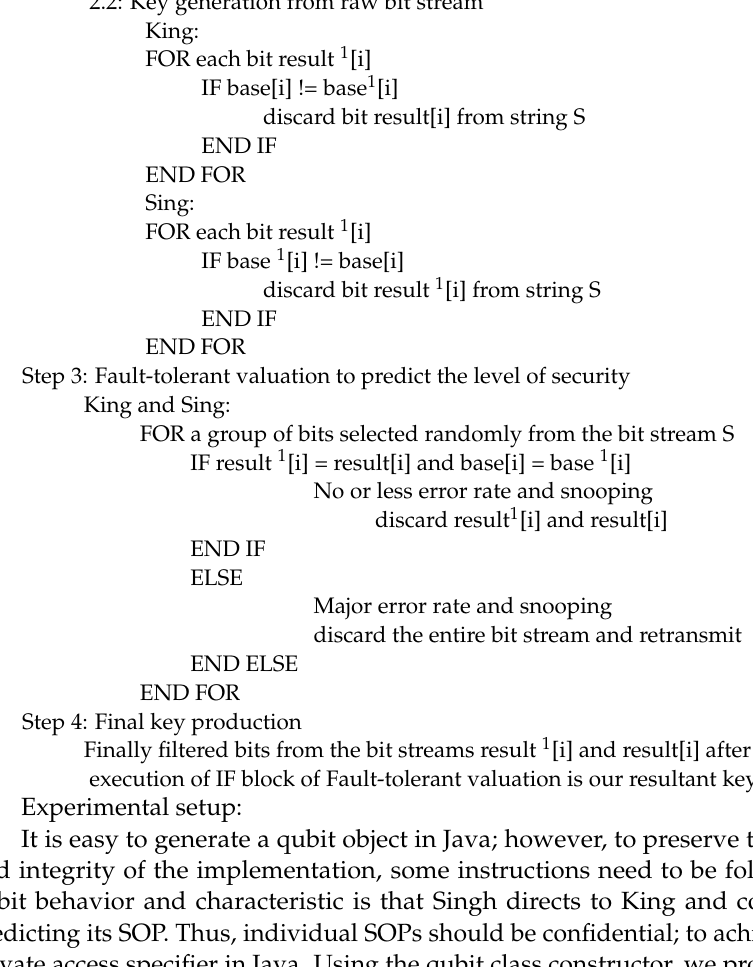
Table 4. The BB84 QKD design standard.